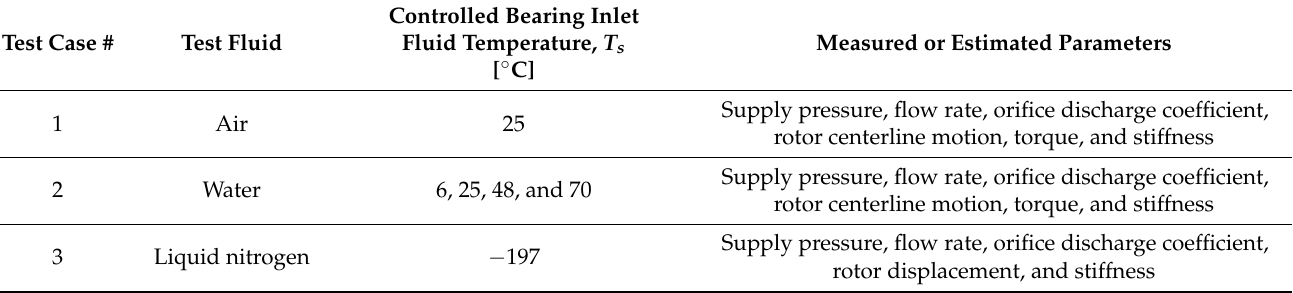
Table 2. Test cases (test fluids, fluid temperature, and measured/estimated